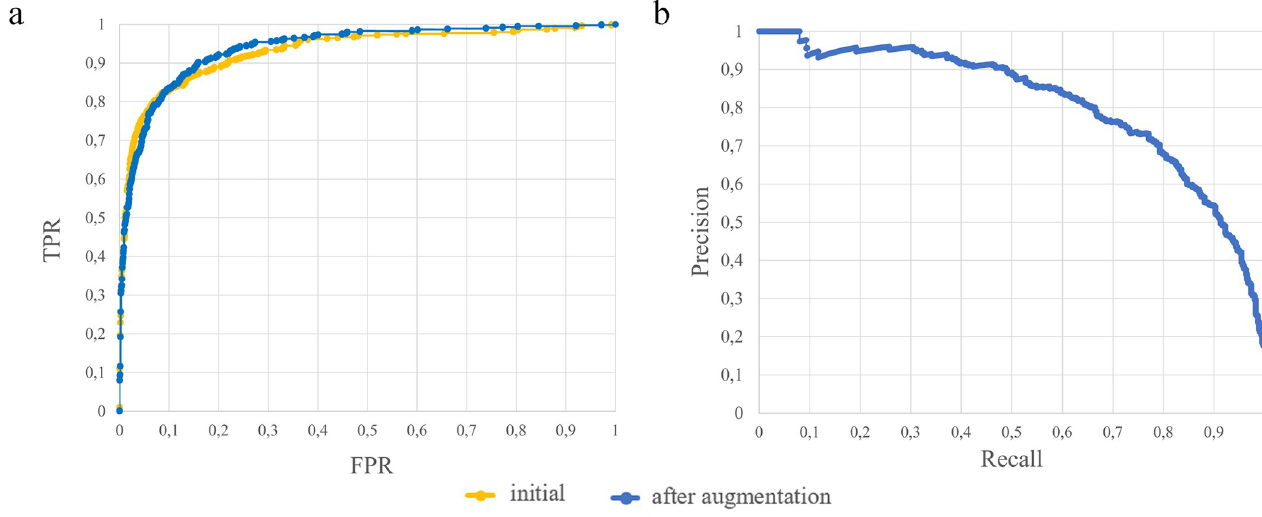
Fig 4. Classifier based on neural networks. a: ROC curve before (yellow) and after (blue) augmentation for the classifier based on unbalanced dataset, b: precision recall curve for the classifier based on unbalanced dataset after augmentation.